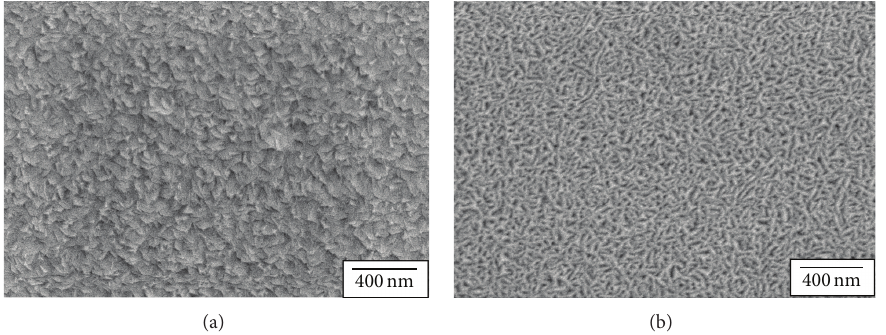
Figure 4: Top surface SEM images of Mo films prepared at a sputtering power of 100W and working pressures of (a) 4.5 mTorr and (b) 12mTorr.